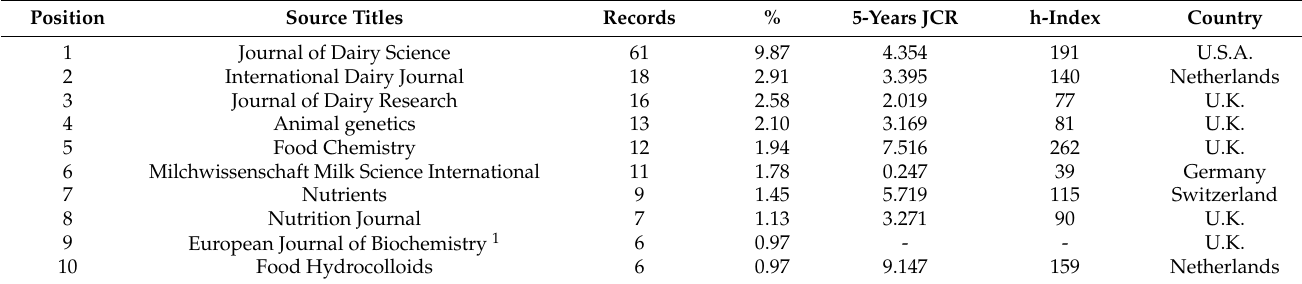
Table 3. Top 10 most productive affiliations in the A2 β -casein research